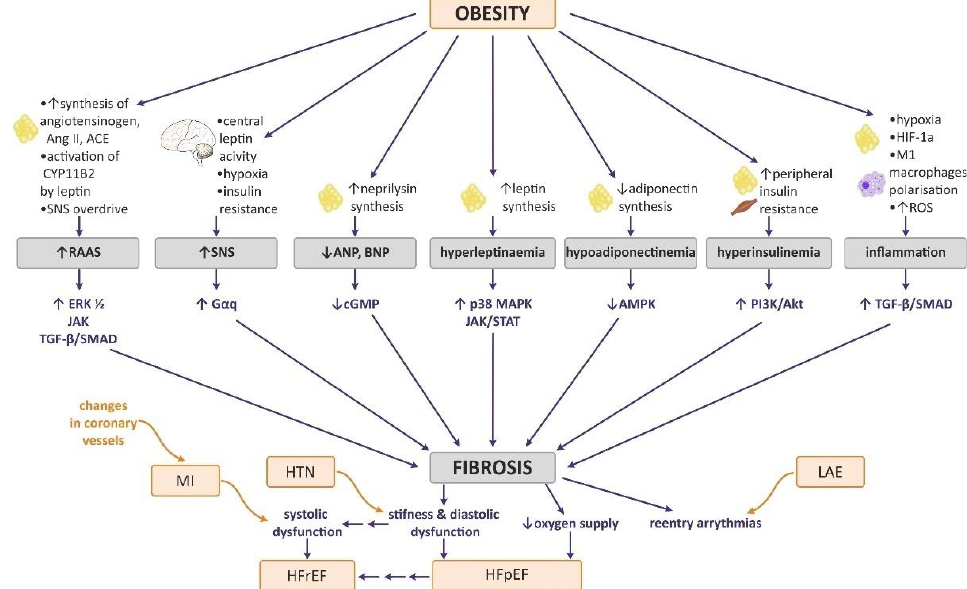
Figure 3. Rationale for cardiac fibrosis in the course of obesity and its clinical sequel. Ang